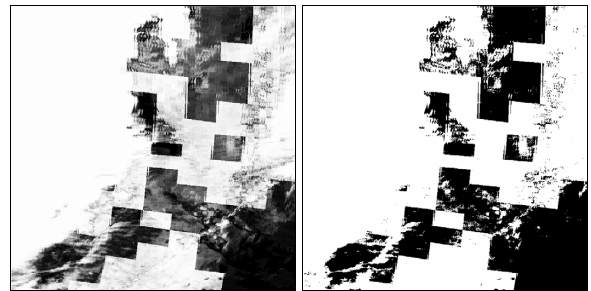
Figure 1. ECM product for 540 km × 540 km. left: cloud probabilities, right: cloud classes; white: cloud, black: